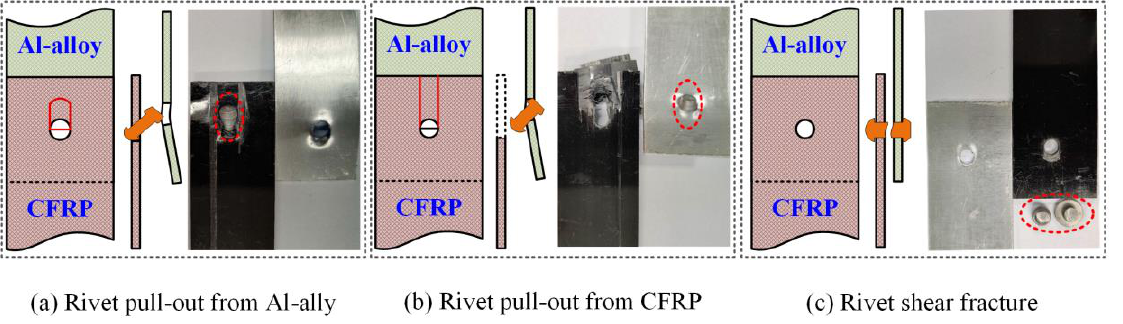
Figure 13. The typical fracture modes for different riveting molds: ( a ) FRM and 22° TRM, ( b ) 44° TRM, ( c ) 66° TRM. TRM, ( c ) 66 ◦ TRM.